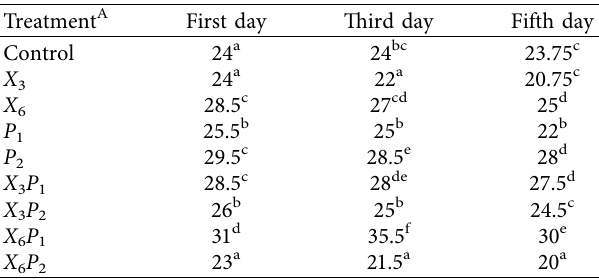
Table 4: Moisture content of baguette bread samples on the first, third, and fifth days of storage